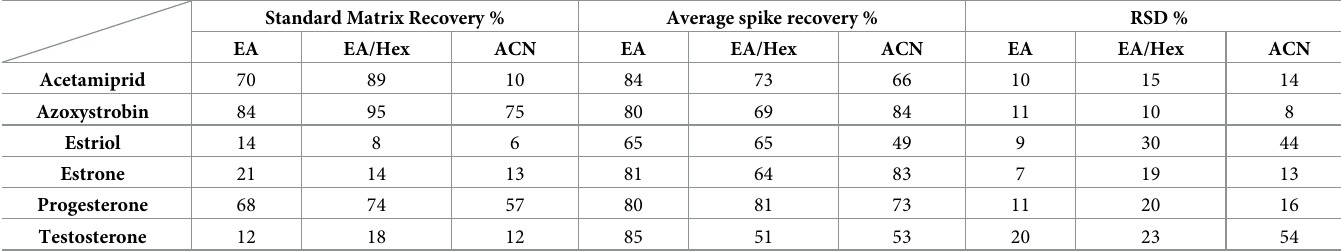
Table 3. Extraction solvent comparison by using different solvents in the liver tissue (n =